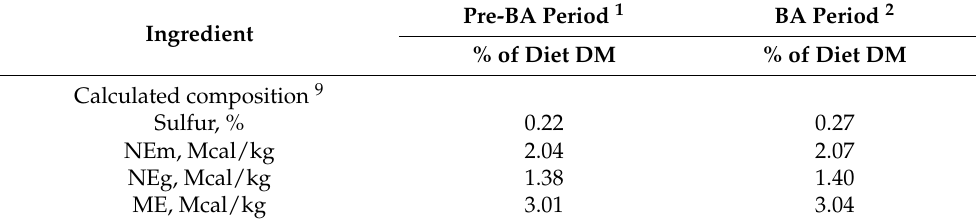
Pre-BA Period 1 BA Period 2 % of Diet DM % of Diet DM